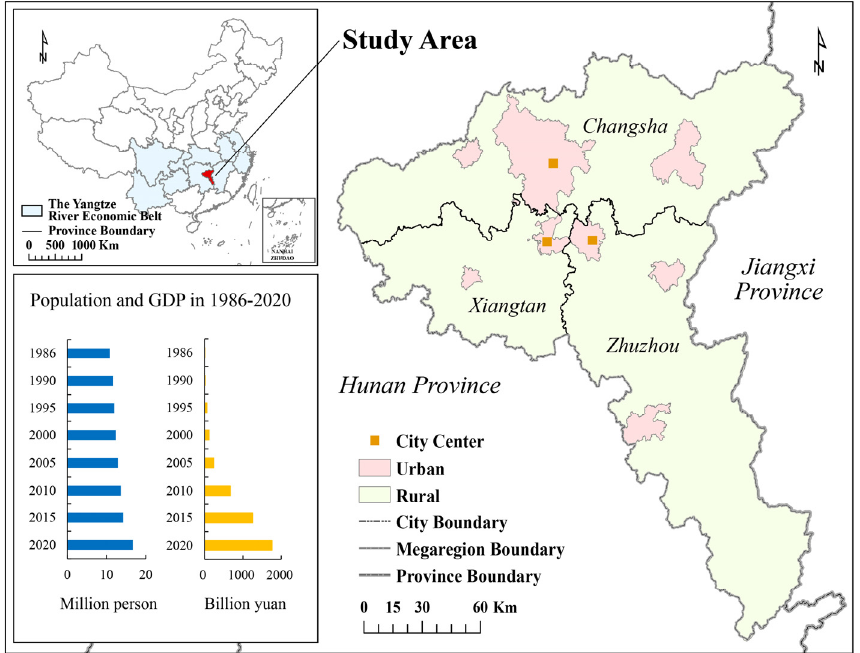
Figure 1. The geographic location of the Changsha—Zhuzhou–Xiangtan urban megaregion. The box at the bottom left is the population and GDP in the CZT urban megaregion and shows the hierarchical administrative boundary.